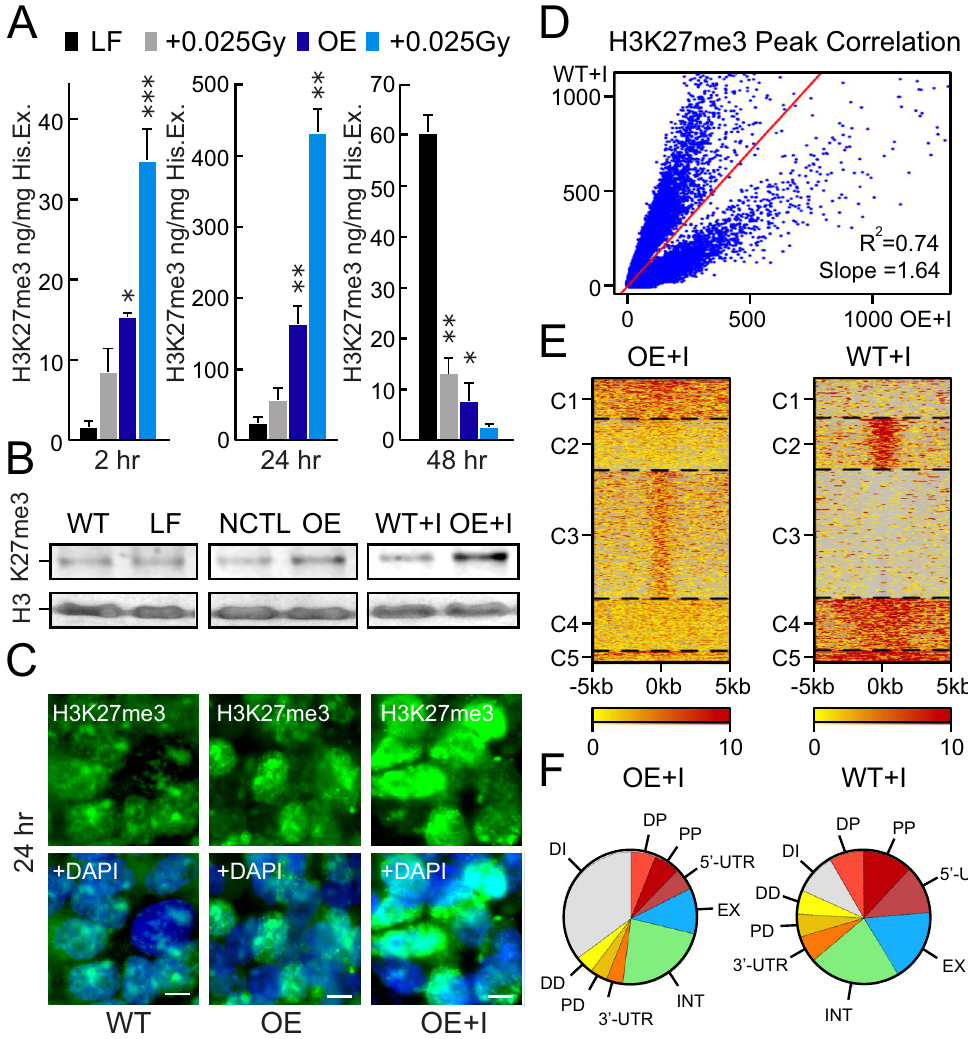
Figure 1. PARTICLE and low dose irradiation act synergistically to enhance the H3K27me3 modification. ( A ) Absolute quantification of H3K27me3 per histone extraction concentration (ng/mg His. Ex.) as determined by ELISA 2 hr, 24 hr or 48 hr in MDA-MB-361 transfected with lipofectamine (LF) or PARTICLE transcript (over- expression: OE) plus or minus exposure to 0.025 Gy. Data are represented as mean ± SEM and the asterisk(s) represent significant values (p < 0.05). ( B ) Representative Western blots of Histone 3 (H3) and H3K27me3 (upper) in MDA-MB-361 (WT) in LF, NC1 control (NCTL) transfected, OE or OE exposed to 0.025 Gy (OE + I). Cropped images of Western blots shown. ( C ) Epifluorescence micrographs of immunofluoresently detected H3K27me3 (green) in MDA-MB-361 at the 24 hr time point in WT, OE or OE exposed to 0.025 Gy (OE + I). DAPI stained nuclei (blue; merged images below). Scale bar 5 μ m. ( D ) Peak correlation scatterplot generated by pairwise comparison of H3K27me3 in irradiated MDA-MB-361 (WT + I) versus irradiated MDA-MB-361 with PARTICLE overexpression (OE + I). ( E ) Heatmaps of H3K27me3 distributions across five clustered differentially active regions (C1–C5) in irradiated MDA-MB-361 (WT + I) versus irradiated MDA-MB-361 with PARTICLE overexpression (OE + I). ( F ) Pie charts illustrating the genome-wide distribution patterns of H3K27me3 in irradiated MDA-MB-361 (WT + I) and irradiated MDA-MB-361 with PARTICLE overexpression (OE + I). DP: Distal Promoter (1–5 Kb); PP: Proximal Promoter (0–1 Kb); 5 ′ UTR: 5 ′ untranslated region; EX: Exon; INT: Intron; 3 ′ UTR: 3 ′ untranslated region; PD: Promoter